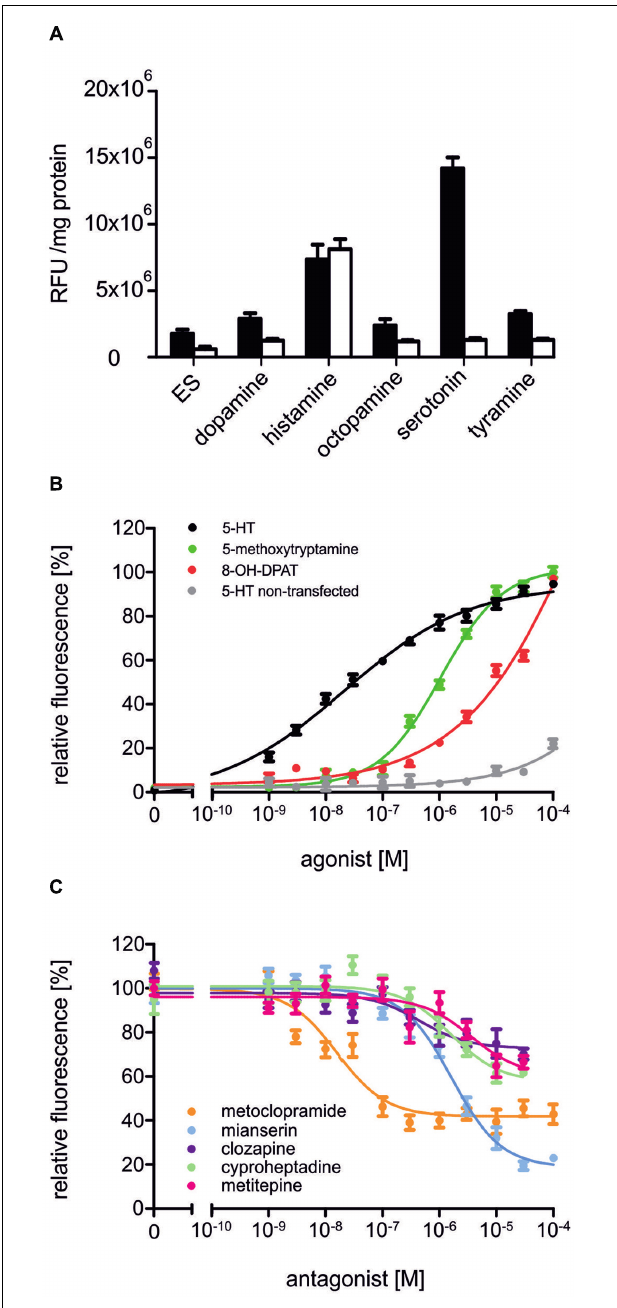
FIGURE 4 | Pharmacological properties of Dm5-HT 2B . (A) Effect of different biogenic amines on Ca 2 + -dependent Fluo-4 fluorescence in Dm5-HT 2B -expressing and non-transfected HEK 293 cells. Bars represent changes in relative fluorescence units (RFU/mg protein) in Dm5-HT 2B -expressing (black bars) and non-transfected HEK 293 cells (white bars). Biogenic amines were applied in a concentration of 10 − 6 M. Mean values ± SD were calculated from octuplicate determinations. ES, extracellular solution. (B) Concentration-dependent effects of serotonin on Dm5-HT 2B -expressing (black) and non-transfected HEK 293 cells (gray) as well as of 5-methoxytryptamine (green) and 8-OH-DPAT (red) on Dm5-HT 2B -expressing cells. Data from representative experiments are shown.